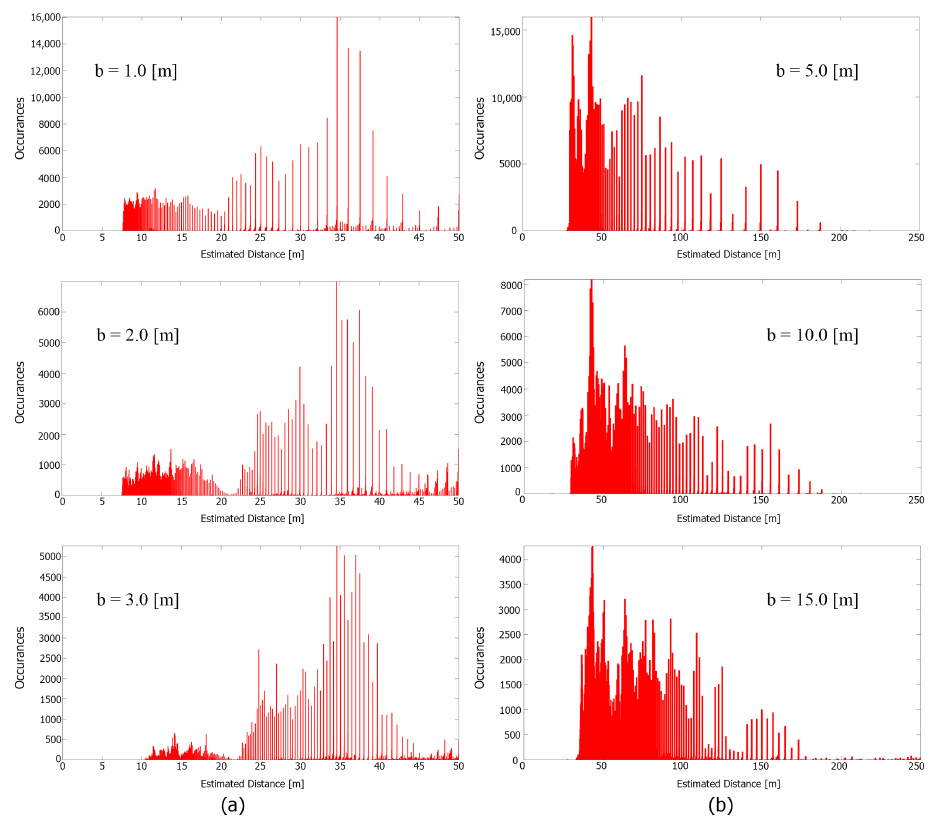
Figure 14. Depth estimation distribution graph with their corresponding baseline from area ( a ) ( left ) and area ( b ) ( right ), where the x-axis is the estimated distance in m, and the y-axis is the number of